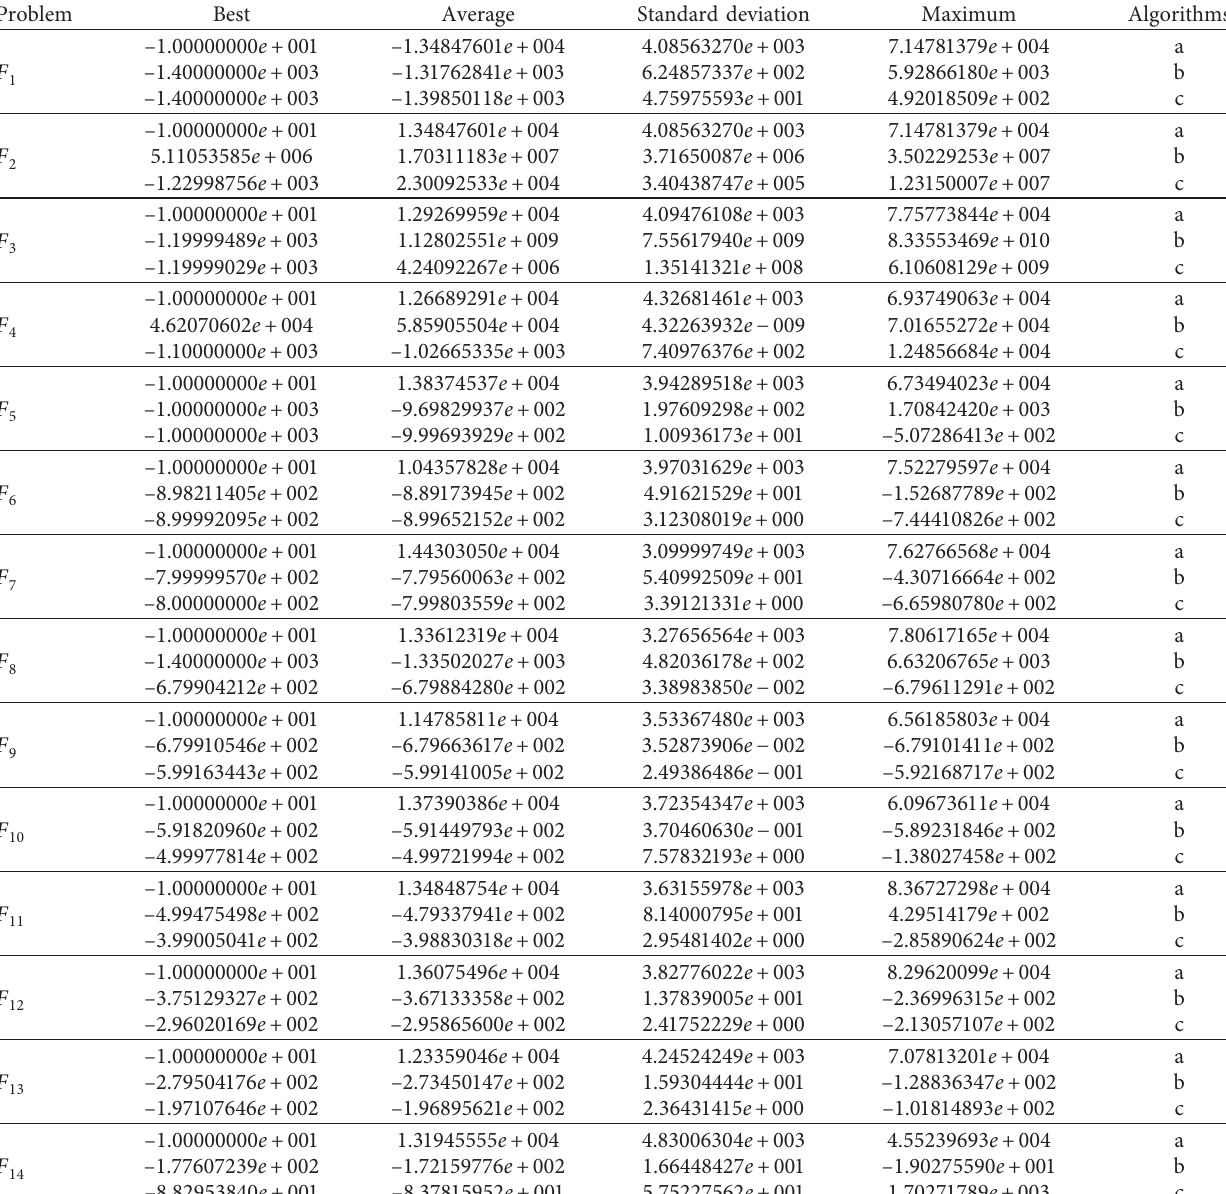
Table 4: The experimental results of (a) MSIA, (b) ACO, and (c) FA by solving the CEC ′ 13 in 30 dimensions [54].